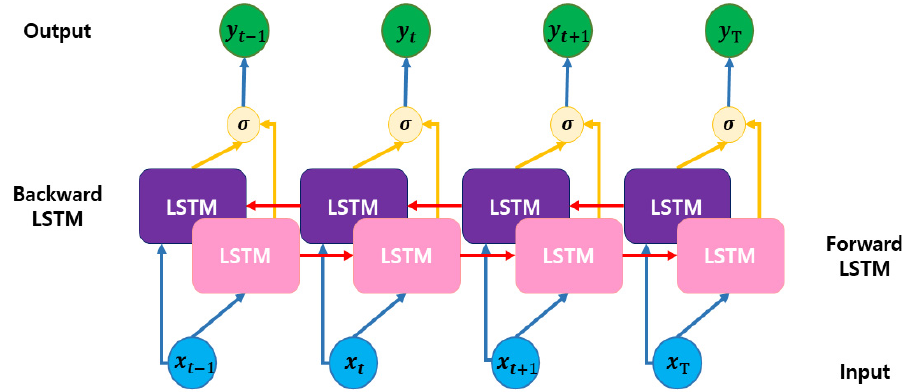
Figure 5. Bi-LSTM